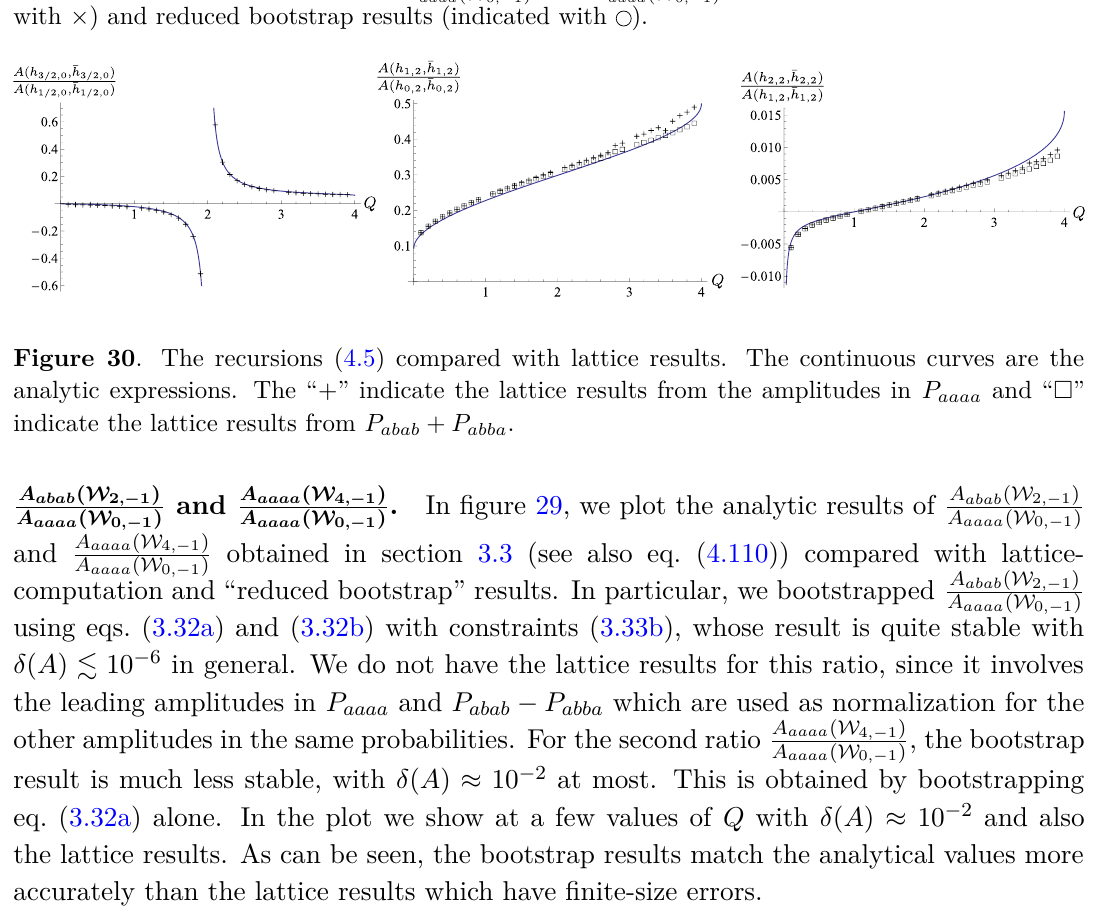
and A aaaa ( W 4 , − 1 ) compared with lattice (indicated A aaaa ( W 0 , − 1 ) A aaaa ( W 0 , − 1 )